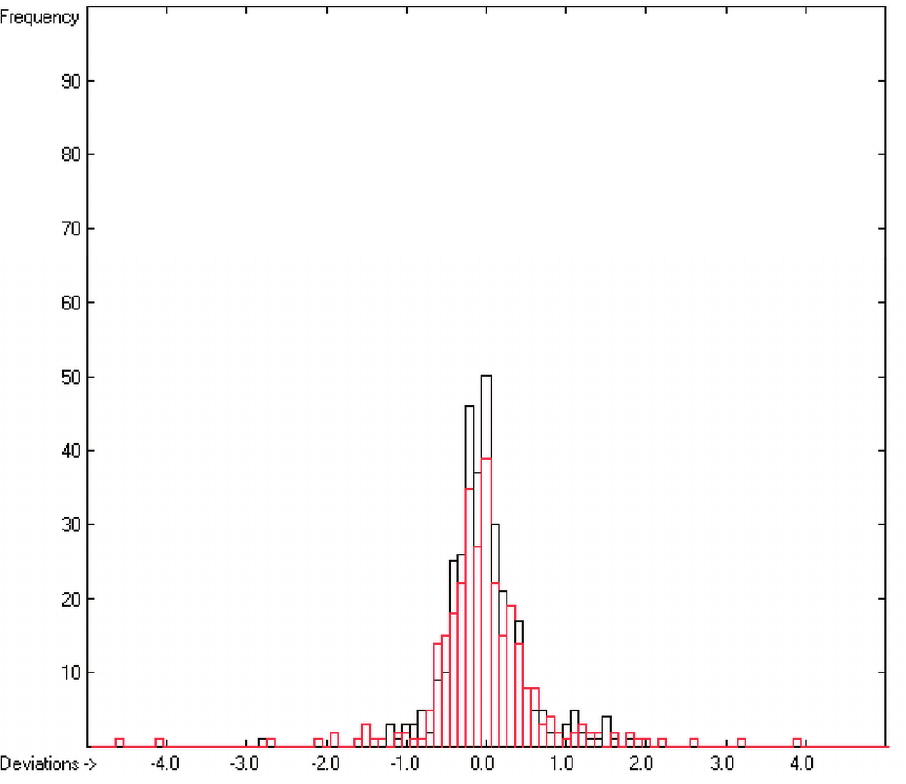
Figure 13. Histogram of polarizability data (S =